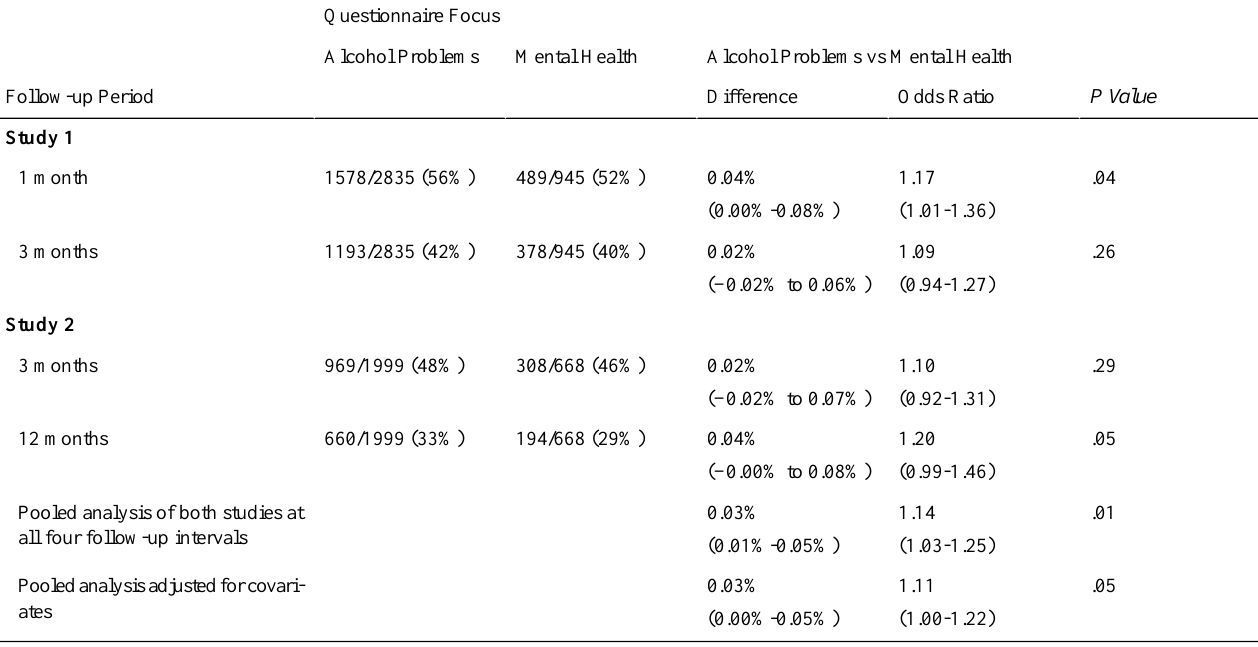
Table 4. Follow-up rates in those allocated to more and less relevant (alcohol problems and mental health respectively) secondary outcome questionnaires Questionnaire